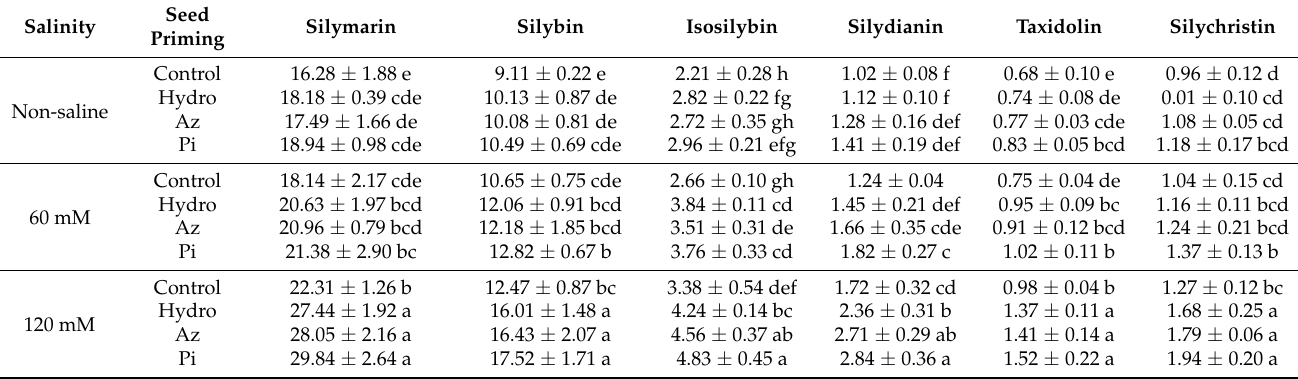
Table 1. Effect of seed priming and salinity on flavonolignans of milk thistle seed (mg · g − 1 DM). Seed Salinity